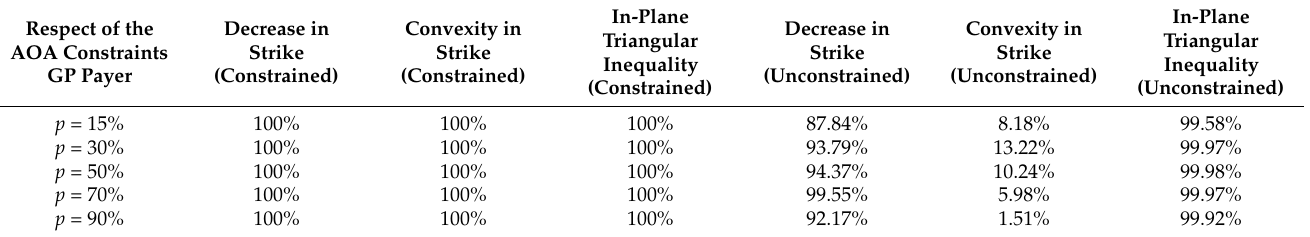
Table 2. Respect of the no-arbitrage constraints for the predicted OTM payer swaptions priced by constrained and unconstrained GP regression, for increasing sizes of training set.